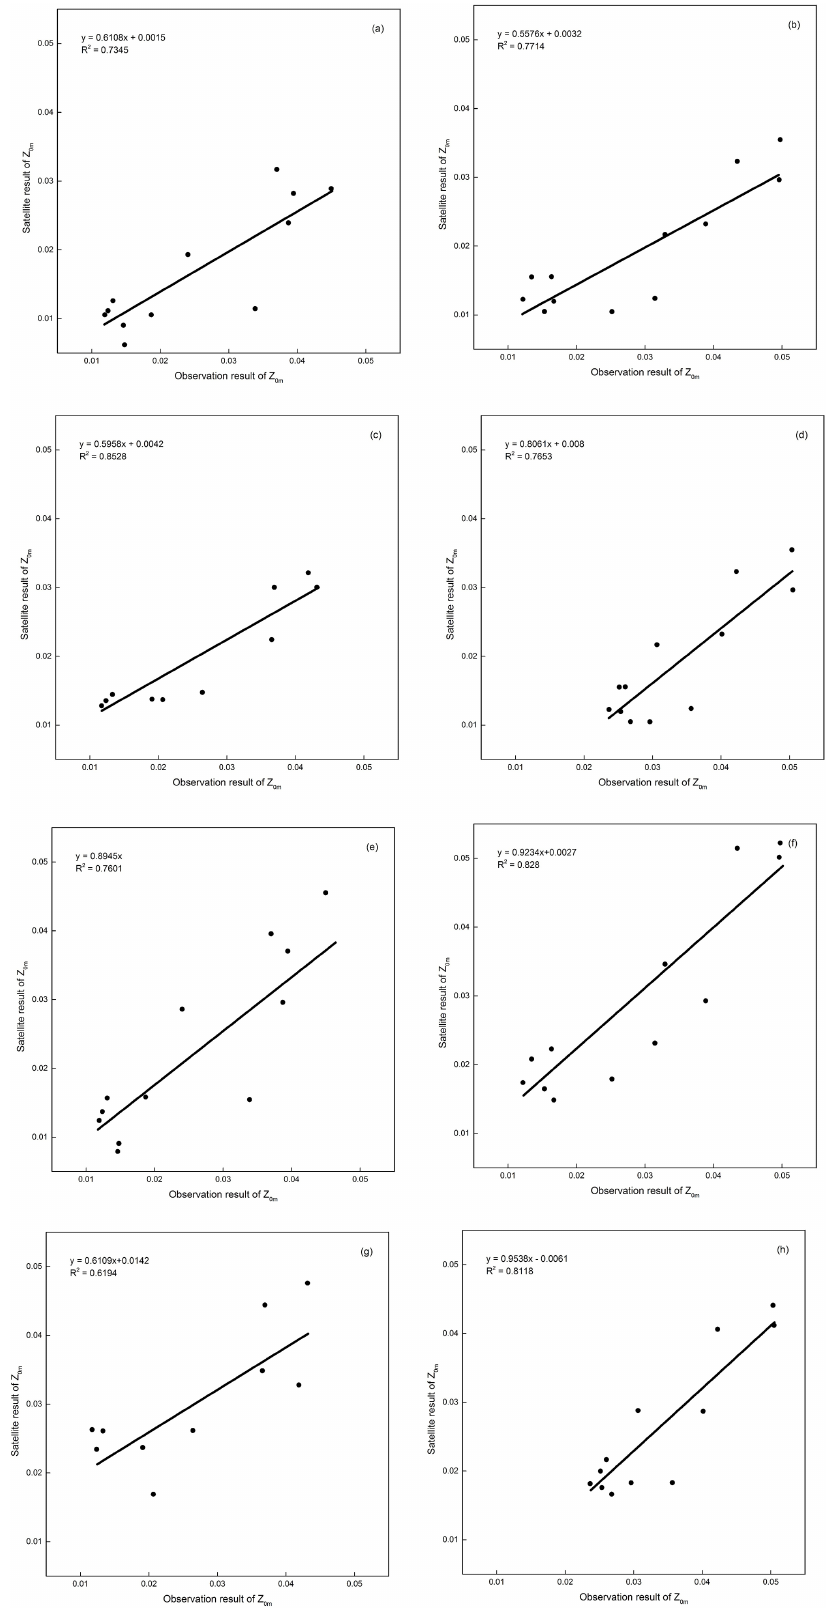
Figure 7. Scatter plots of the retrieved and calculated surface roughness lengths at four